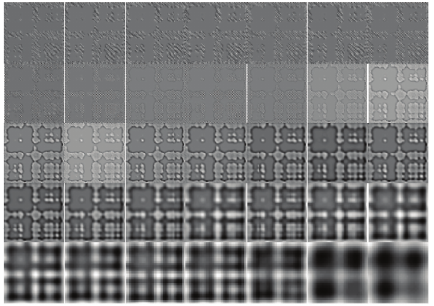
Figure11:TheDOGscalespaceoftheelementfaultundercondition